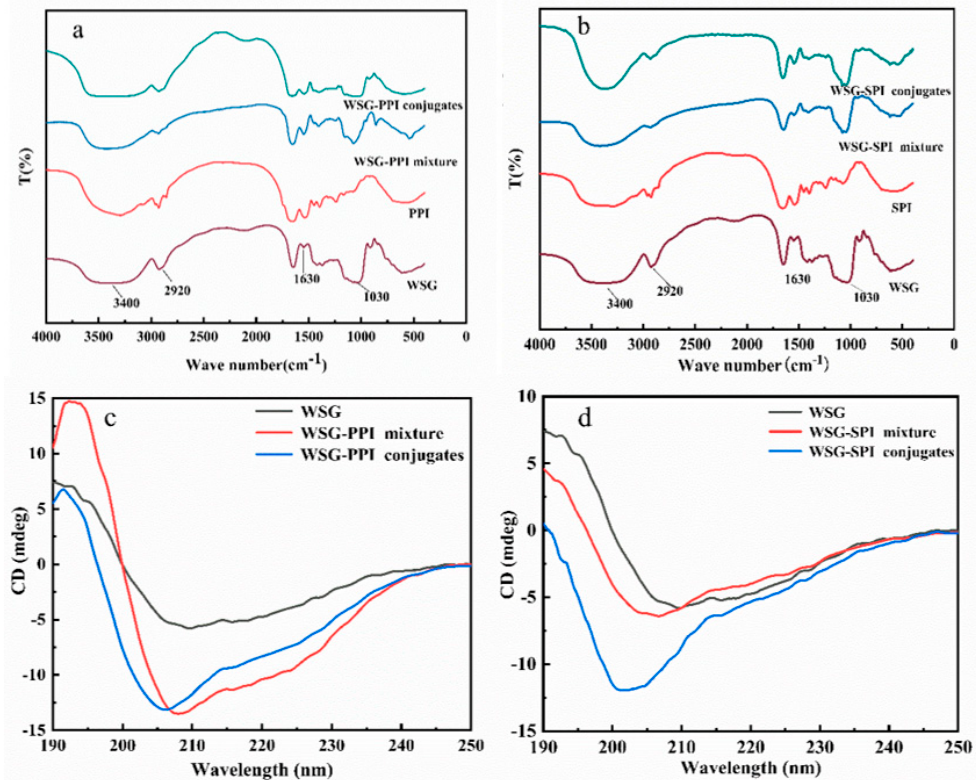
Figure 4. FT-IR spectra and CD spectra of WSG and its conjugates. ( a ) FT-IR spectra of WSG-PPI conjugates; ( b ) FT-IR spectra of WSG-SPI conjugates; ( c ) CD spectra of WSG-PPI conjugate; ( d ) CD spectra of WSG-SPI conjugates.